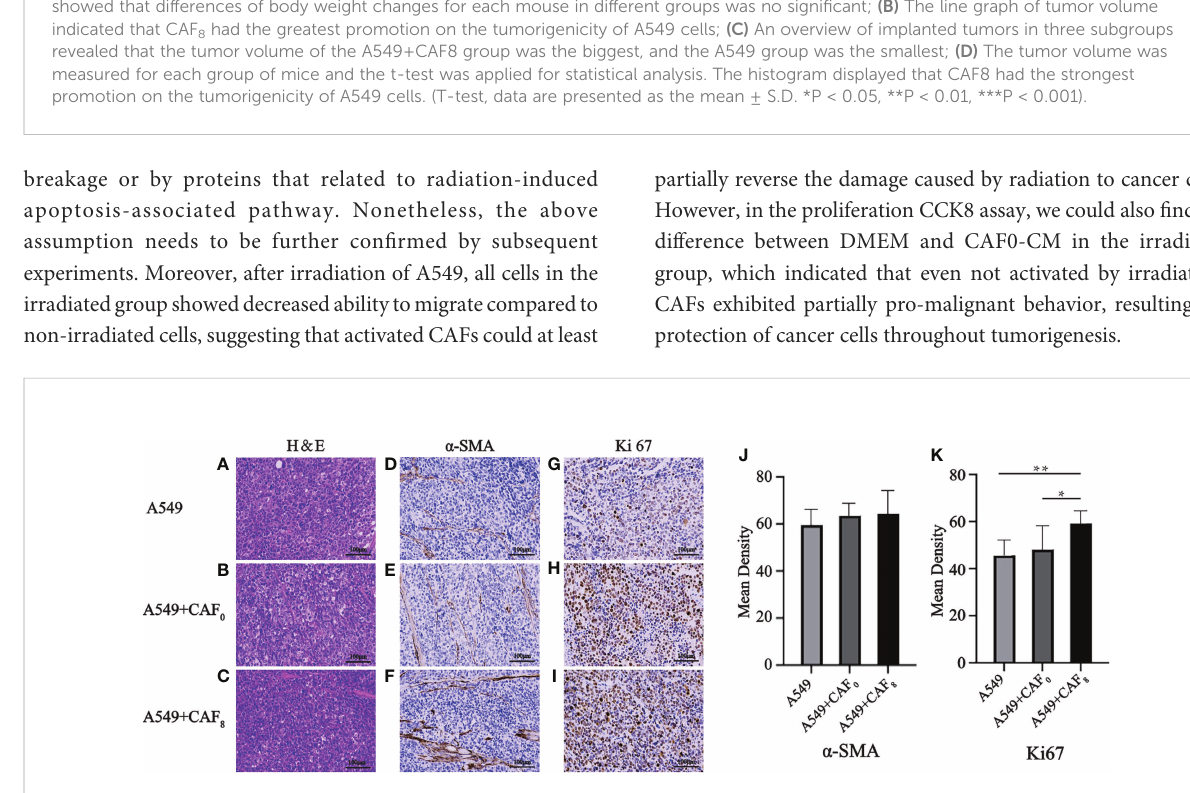
FIGURE 8 Hematoxylin and eosin (H&E) and immunohistochemical staining of the exfoliated tumor tissues were used to detect histopathological features and expression of a -SMA and Ki67 in A549, A549+CAF 0, and A549+CAF 8 subgroups. (A – C) Representative images of H&E staining for three subgroups; (D – F) Immunohistochemical staining of a -SMA of three subgroups; (G – I) . Immunohistochemical staining of Ki67 of three subgroups; (J, K) The histogram of the mean density of a -SMA positive staining area (J) and Ki67 positive staining area (K) in the samples from all groups. (T-test, data are presented as the mean ± S.D. * P < 0.05, ** P <